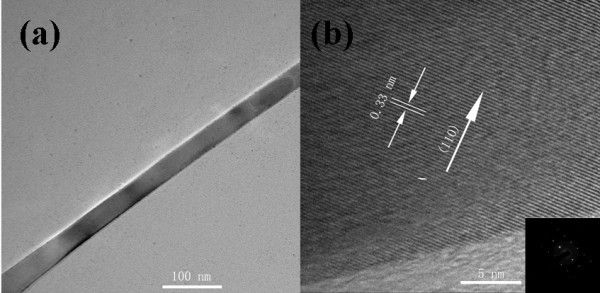
TEM image of SnO2 nanobelt. (a) TEM image of SnO2 nanobelt. (b) HRTEM of single SnO2 nanobelt. An inset image of (b) is diffraction pattern of SnO2 nanobelt.